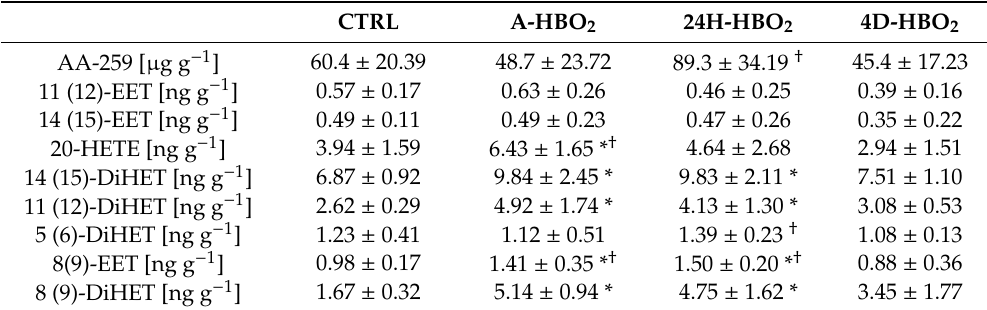
Table 3. Liquid chromatography-tandem mass spectrometry (LC / MS–MS) determination of CYP450 enzymatic pathway vasodilating 11(12)-epoxyeicosatrienoic acid (EET), 14(15)-EET, 8(9)-EET and corresponding DiHETs and vasoconstriction-causing metabolite (20- hydroxy-eicosatrienoic acid (HETE)) of arachidonic acid in aortic tissue. CTRL A-HBO 2 24H-HBO 2 AA-259 [ µ g g − 1 ]